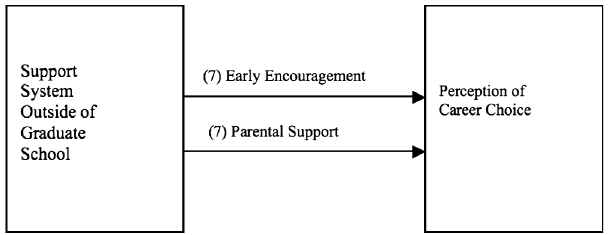
FIG. 4. 2B. How does their support system outside of school impact their perception of their career choice?